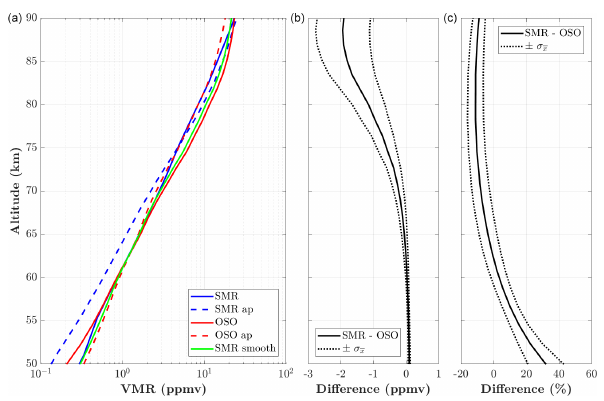
Figure 13. SMR–OSO comparison for 2002–2007. (a) Blue solid/dashed are the average SMR retrieved/a priori profiles, red solid/dashed are the average OSO retrieved/a priori profiles and green is the smoothed SMR profile. (b, c) The average difference between the smoothed SMR and OSO profiles, solid, together with the standard error of the mean, σ x , dotted, is shown in parts per million by volume and percent, respectively.